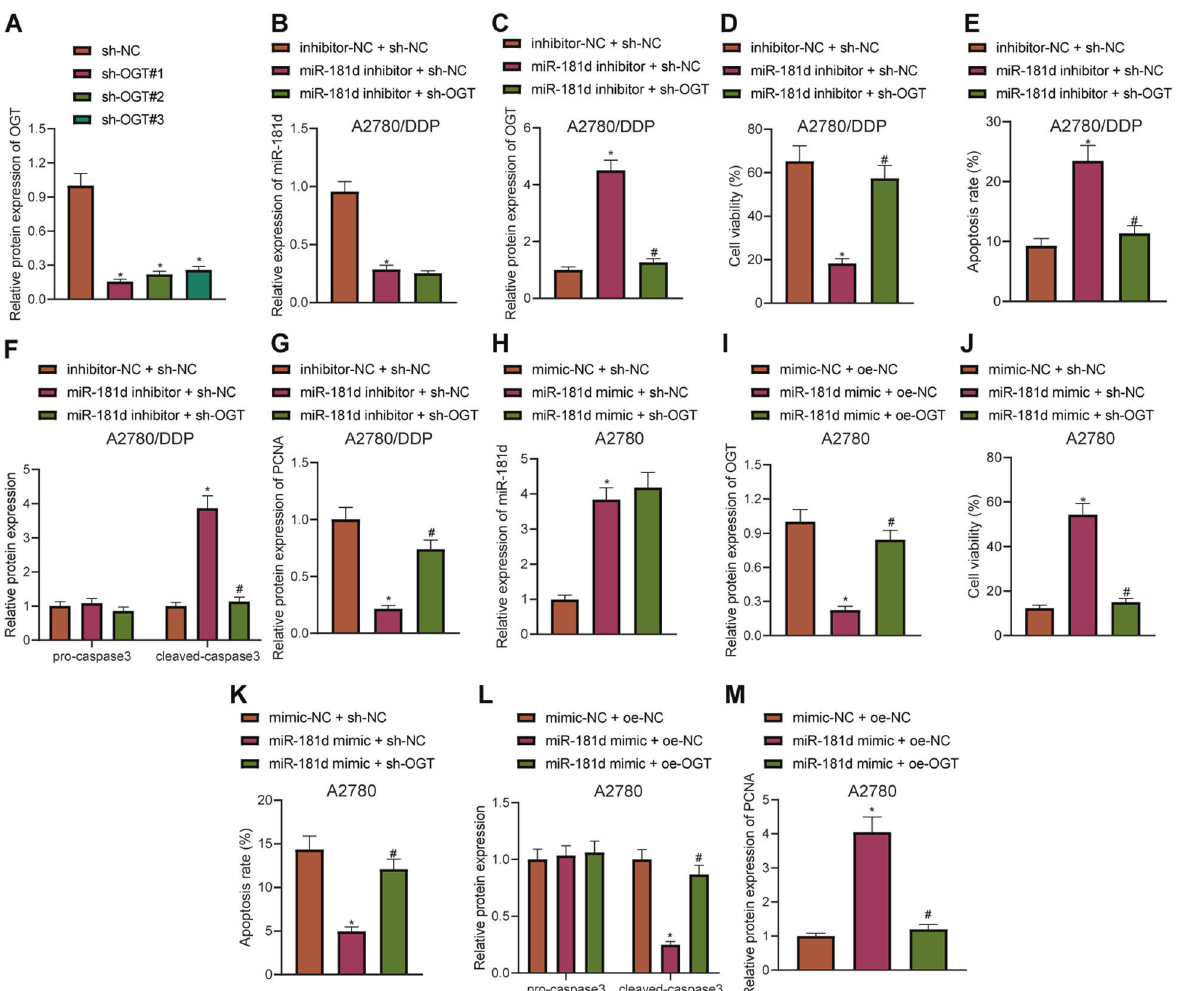
Fig. 4 miR-181d promotes resistance of OC cells to DDP by downregulating OGT. A Western blot assay of sh-OGT knockdown ef fi ciency in A2780/DDP cells. A2780/DDP cells were treated with inhibitor-NC + sh-NC, miR-181d inhibitor + sh-NC, or miR-181d inhibitor + sh-OGT. B RT- qPCR detection of miR-181d expression in A2780/DDP cells normalized to U6. C Western blot assay of OGT expression in A2780/DDP cells normalized to β -actin. D CCK-8 assay of A2780/DDP cell viability. E Flow cytometric detection of A2780/DDP cell apoptosis. F Western blot assay of pro-caspase3 and cleaved caspase-3 expression and quantitative analysis in A2780/DDP cells normalized to β -actin. G Western blot assay of PCNA expression and quantitative analysis in A2780/DDP cells normalized to β -actin. A2780 cells were treated with mimic-NC + oe- NC, miR-181d mimic + oe-NC, or miR-181d mimic + oe-OGT. H RT-qPCR detection of miR-181d expression in A2780 cells normalized to U6. I Western blot assay of OGT expression in A2780 cells normalized to β -actin. J CCK-8 assay of A2780 cell viability. K Flow cytometric detection of A2780 cell apoptosis. L Western blot assay of pro-caspase3 and cleaved caspase-3 expression and quantitative analysis in A2780 cells normalized to β -actin. M Western blot assay of PCNA expression and quantitative analysis in A2780 cells normalized to β -actin. Cell experiments were repeated three times independently. * p < 0.05 versus A2780/DDP cells treated with sh-NC, or inhibitor-NC + sh-NC or A2780 cells treated with mimic-NC + oe-NC. # p < 0.05 versus A2780/DDP cells treated with miR-181d inhibitor + sh-NC or A2780 cells treated with miR-181d mimic +